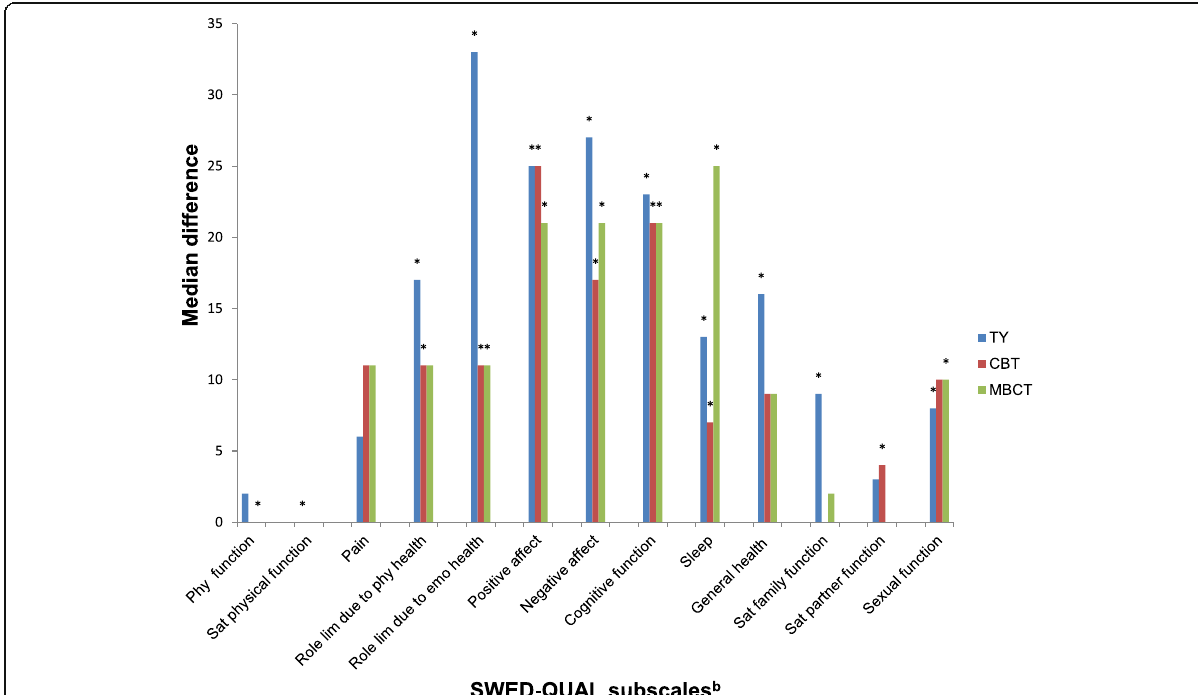
Fig. 2 Test of treatment effect (post-pre) a in SWED-QUAL b median, subscales scores, ranging from 0 (worst) to 100 (best) possible, after 20 weeks treatment with Traditional Yoga (TY), Cognitive Behavioral Therapy (CBT) (control) or Mindfulness-based Cognitive Therapy (MBCT). Significant p -values, P < 0.05, and after Holm-Bonferroni correction are indicated by (*).Legend: a Wilcoxon ’ s sign-rank test was used for comparisons in